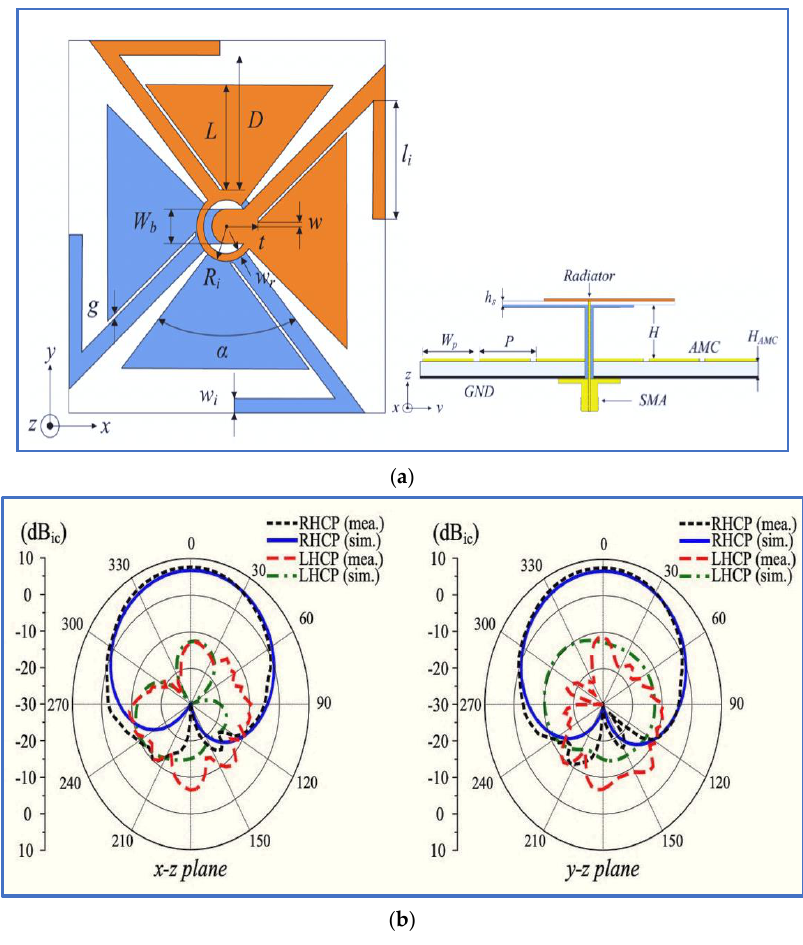
Figure 5. A proposed CP antenna: ( a ) geometry and ( b ) radiation pattern at 2.4 GHz [51]. Quadrilateral dipole patches (kite-shaped patches) and bowtie-shaped feedline were used by [15], as shown in Figure 6, to realise a wide IBW. The method for generating circular polarisation involves two bent slots which are introduced to one kite-shaped patch due to the 90° PD achieved after employing the two slots. The proposed design can realise CP waves with two rotation directions (LHCP and RHCP) simply by introducing impeding slots into the other kite-shaped patch. However, the proposed antenna offers an IBW of 62.6% and ARBW of 37% with an antenna gain of 6 dBi. Other current works on the nonplanar indoor antenna with different techniques and shapes were reported by [53 – 56].